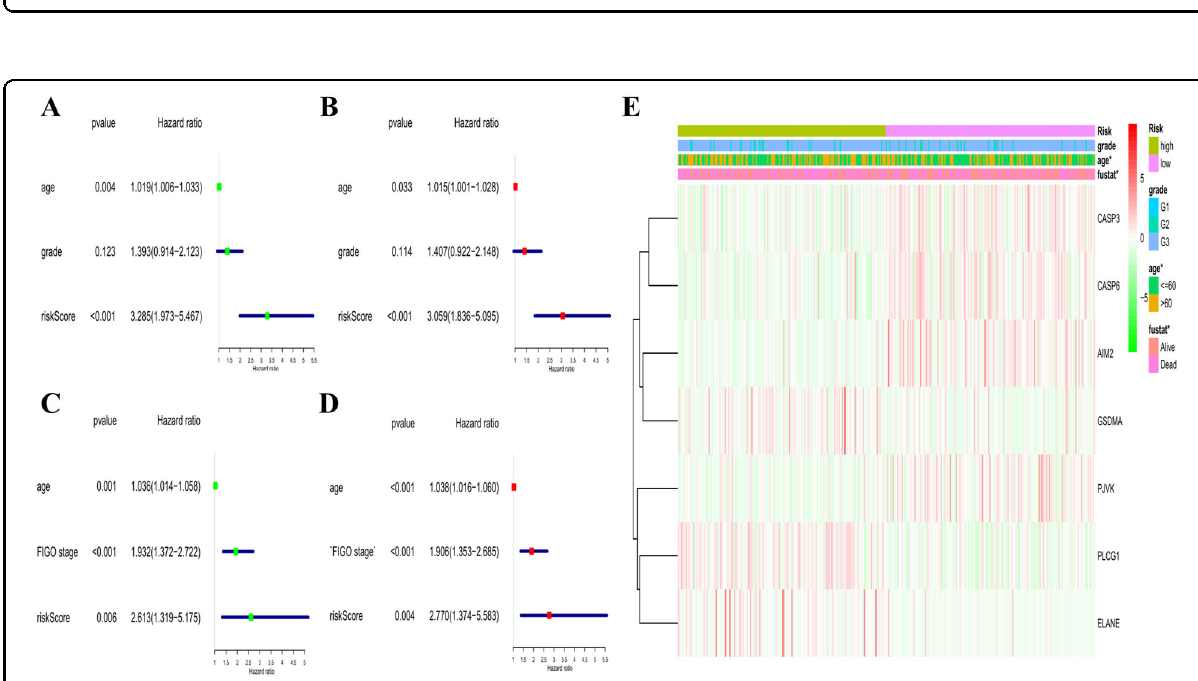
Fig. 4 Validation of the risk model in the GEO cohort. A Distribution of patients in the GEO cohort based on the median risk score in the TCGA cohort. B PCA plot for OCs. C The survival status for each patient (low-risk population: on the left side of the dotted line; high-risk population: on the right side of the dotted line). D Kaplan – Meier curves for comparison of the OS between low- and high-risk groups. E Time-dependent ROC curves for OCs.